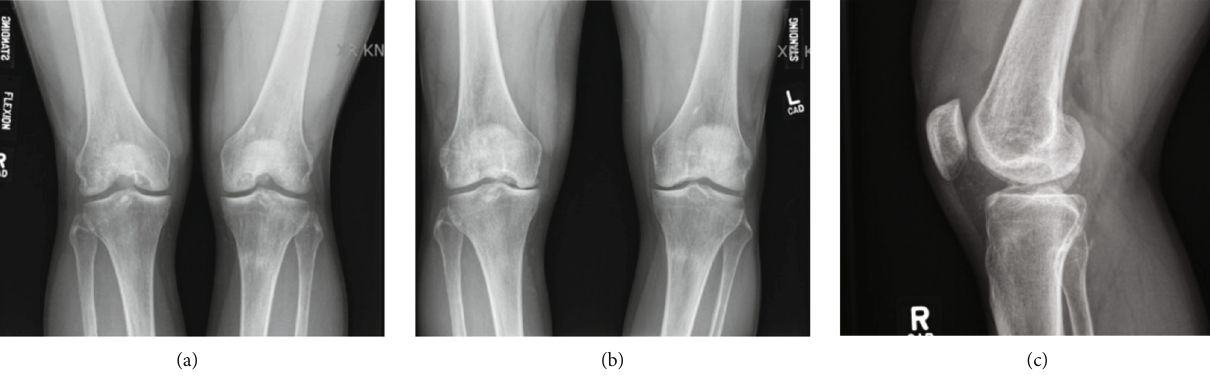
Figure 2: Preoperative radiographs. (a) Posterior-anterior weight-bearing view. (b) Anterior-posterior weight-bearing view. (c) Lateral